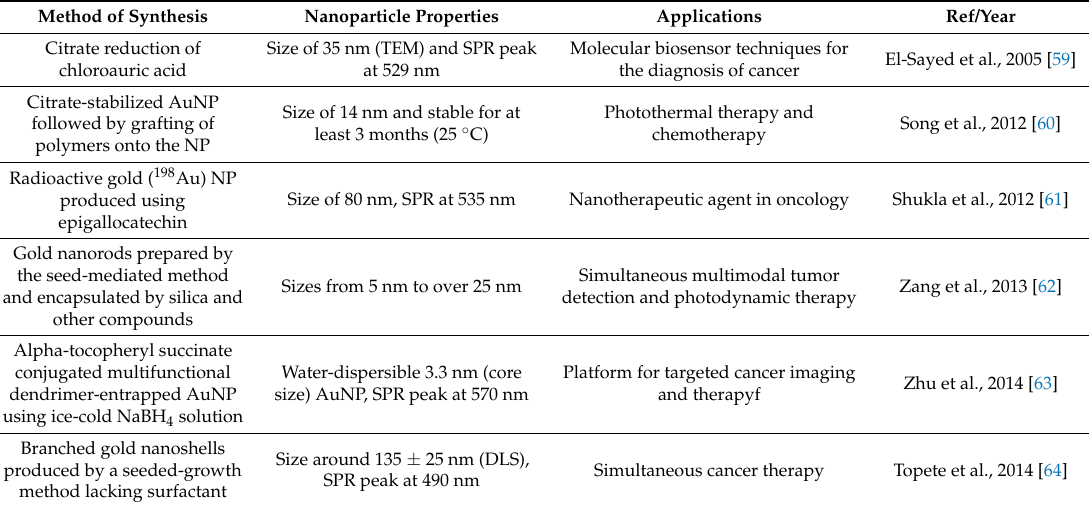
Table 1. An updated review of the applications of gold nanoparticles